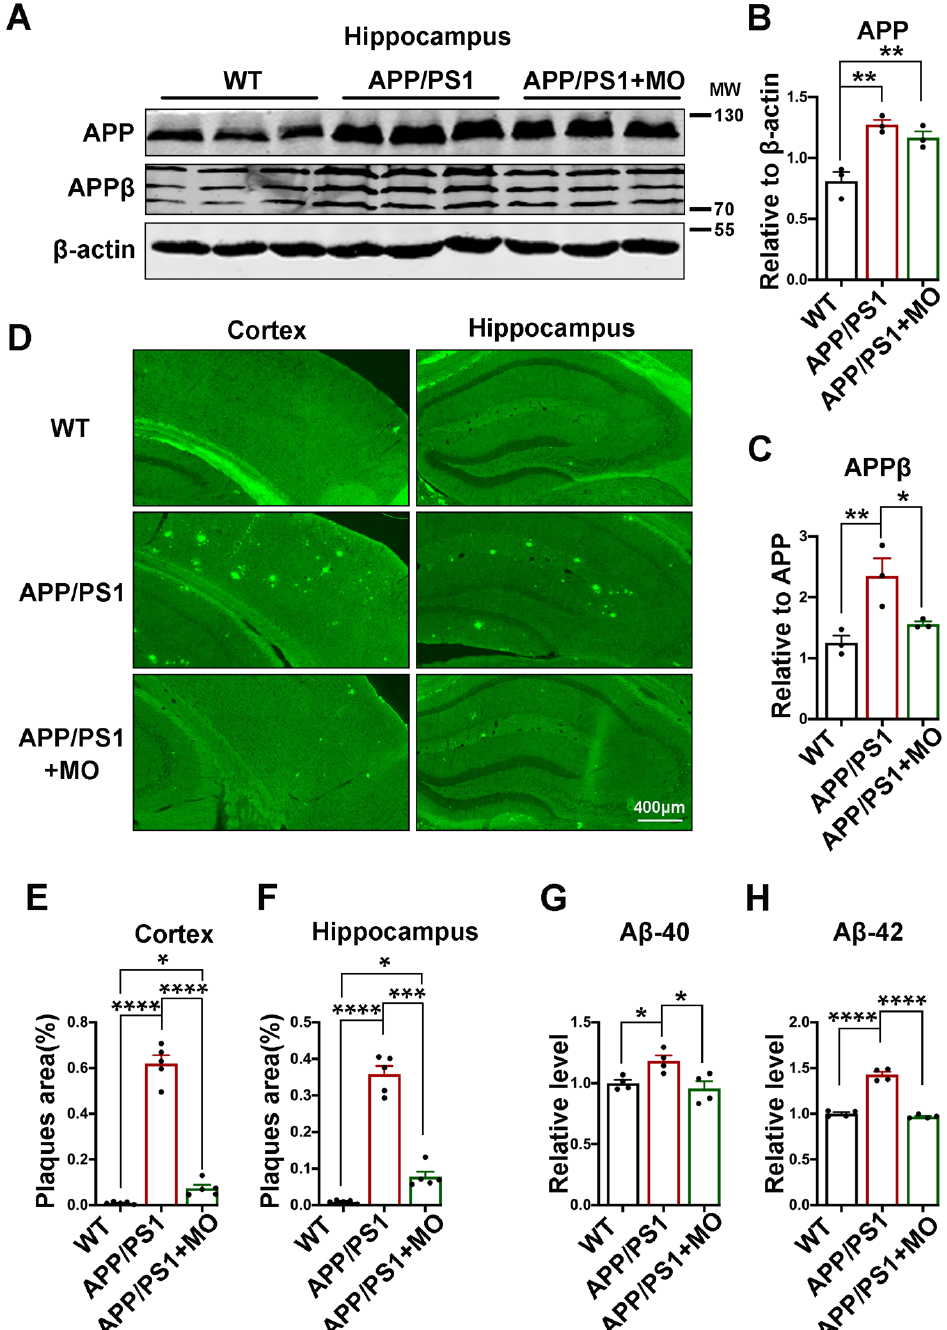
Figure 2. Long-term MO treatment alleviates the A β burden in APP/PS1 mice. ( A ) The expression of APP and APP β from hippocampal lysates of WT control and APP/PS1 mice with or without MO treatment was evaluated by Western blotting, ( n = 3). β -actin serves as the loading control. ( B , C ) Statistical analysis of APP and APP β . ( D ) Representative images of thioflavin S staining from WT control and APP/PS1 mice with or without MO treatment (scale bare = 400 µ m, n = 3). ( E , F ) The quantification of thioflavin S fluorescence of the % areas occupied by the A β plaques in the cortex and hippocampus. ( G , H ) The statistical analysis of the ELISA test for A β 40 and A β 42 from hippocampal lysates of WT control and APP/PS1 mice with or without MO treatment ( n = 4). The data are presented as Mean ± SEM. * p < 0.05; ** p < 0.01; *** p < 0.001; and **** p < 0.0001 vs. WT or vs. APP/PS1 mice